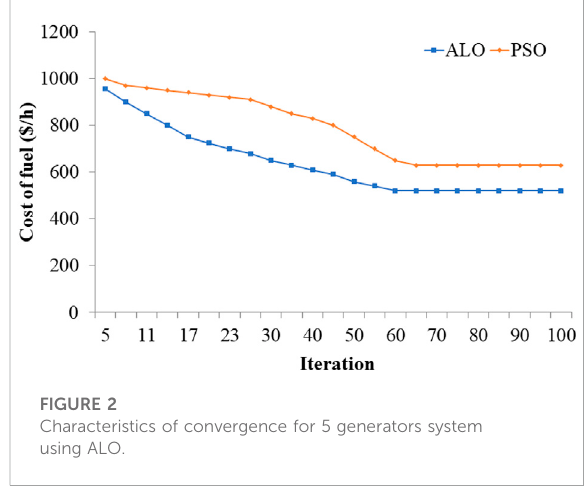
FIGURE 2 Characteristics of convergence for 5 generators system using ALO.